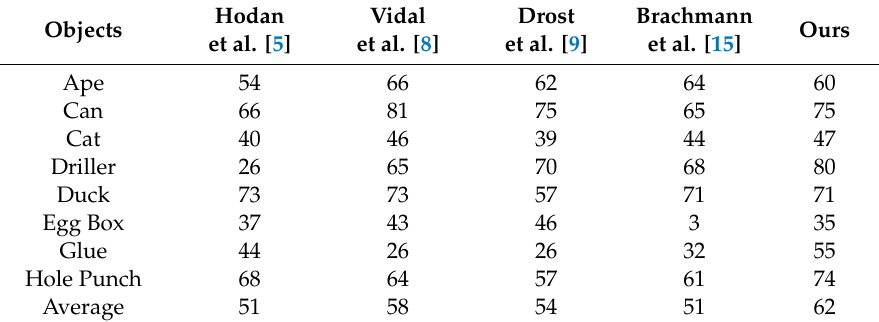
Table 3. Detection rates of methods on the Occlusion dataset (%).